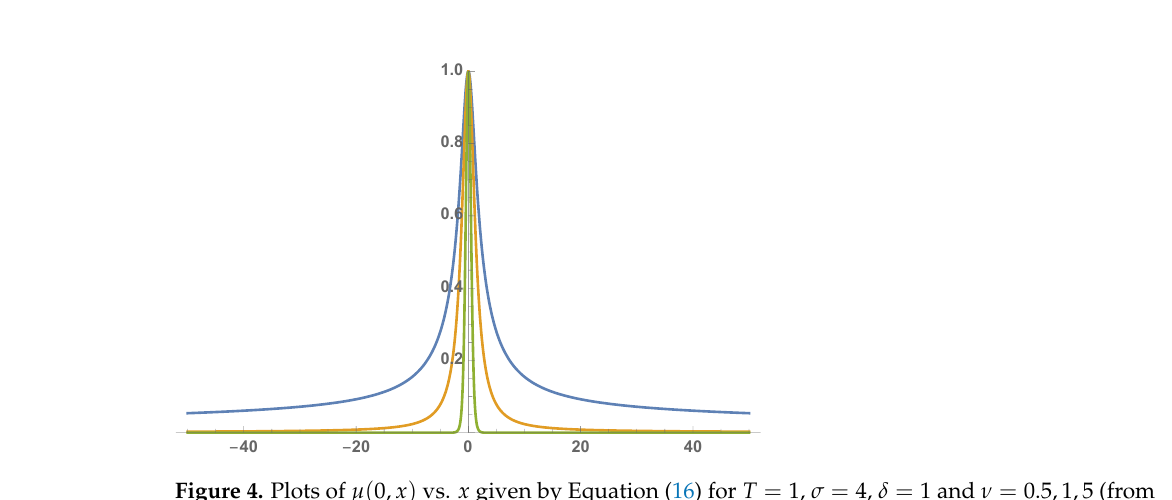
Figure 4. Plots of µ ( 0, x ) vs. x given by Equation (16) for T = 1, σ = 4, δ = 1 and ν = 0.5,1,5 (from the widest to the narrowest curve).